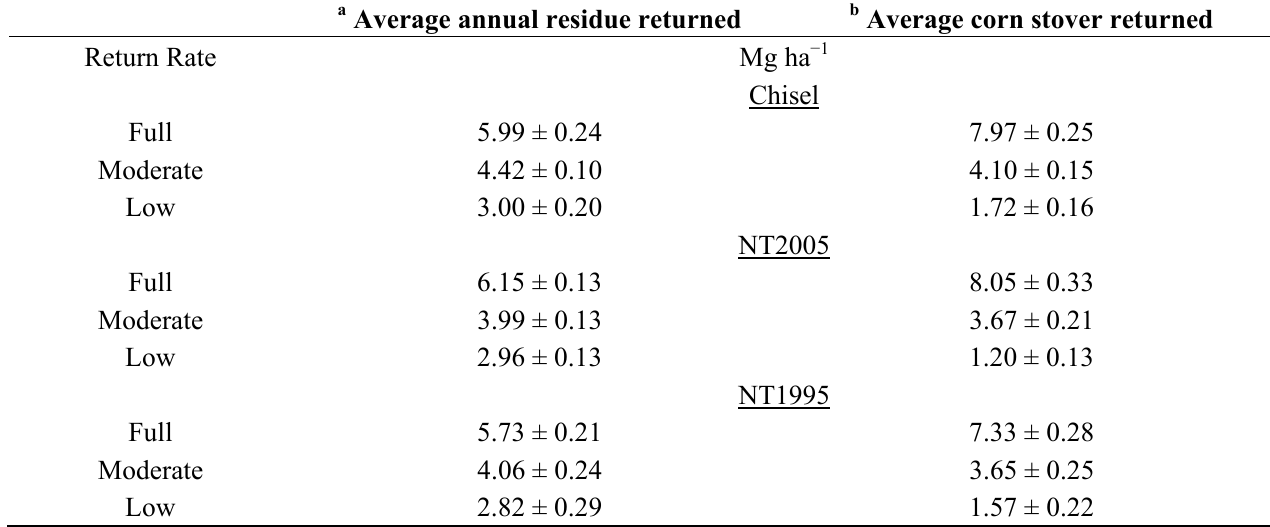
Table 1. Average dry residue (corn stover and soybean straw) and dry corn stover retained from 2005 to 2011 in Chisel and No tillage since 1995 (NT1995) fields and from 2006 to 2011 in no tillage since 2005 (NT2005) field. Corn stover remaining measured except in 2006, when corn stover remaining in the field was estimated from measured 2005 and 2007 stover yield and the ratio of returned stover. (Mean ± standard error, n =